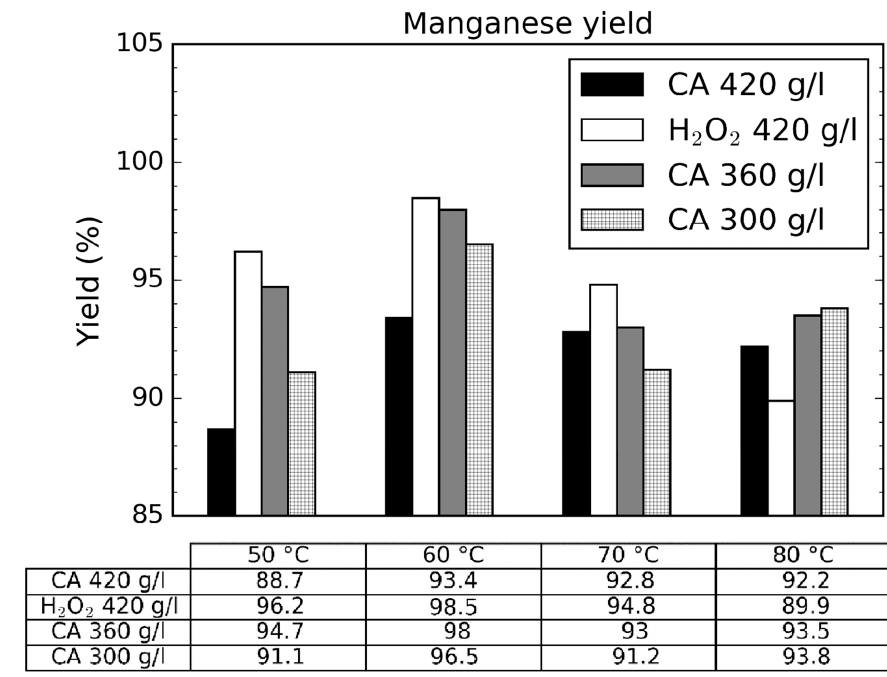
Figure 8. Effect of leaching conditions on manganese recovery rate after 180 min of reaction time.